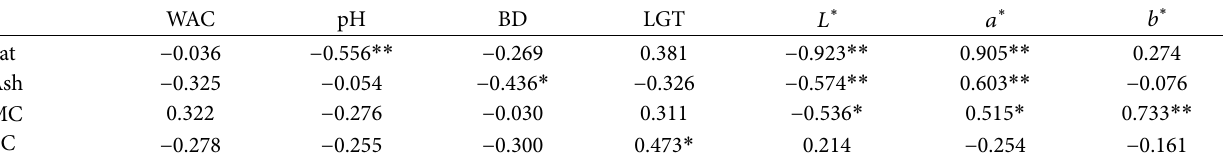
** Correlation is significant at the 0.01 level (2-tailed) and * Correlation is significant at the 0.05 level (2-tailed). WAC = water absorption capacity, BD = bulk density, PC: protein content, LGT = least gelation concentration, 𝐿 ∗ = lightness, 𝑎 ∗ = redness and 𝑏 ∗ =